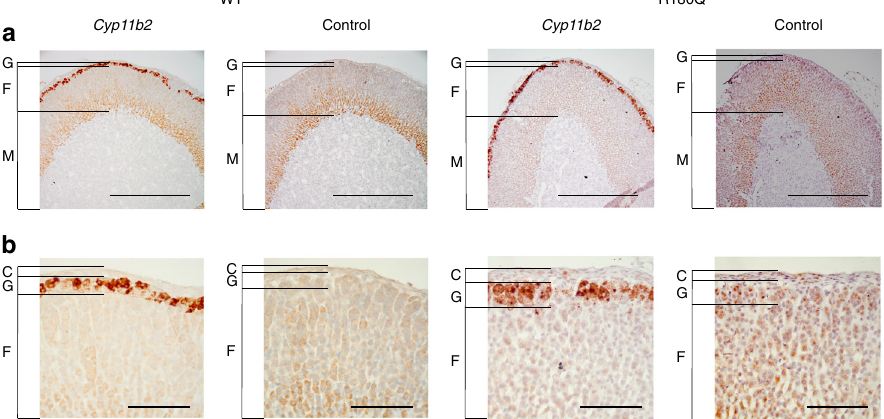
Fig. 3 Cyp11b2 expression in adrenal glands of Clcn2 R180Q/ + mice. Adrenal sections of WT and Clcn2 R180Q/ + mice (one of six stainings each is shown. C capsule, G glomerulosa, F fasciculata, M medulla) stained by in situ hybridization for Cyp11b2 , with corresponding negative controls (see Methods). ( a ) scale bar, 500 µ m. ( b ) scale bar, 100 µ